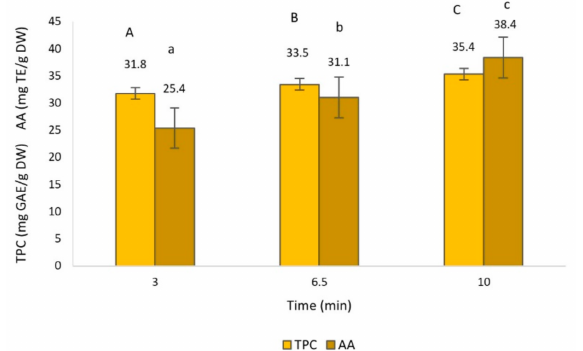
Figure 2. Total phenol content (TPC) and antioxidant activity (AA) of olive leaf extract obtained by microwave-assisted extraction (MAE) as a function of treatment time. Different capital and lowercase letters above the bars represent groups significantly different at p < 0.05 of TPC and AA,